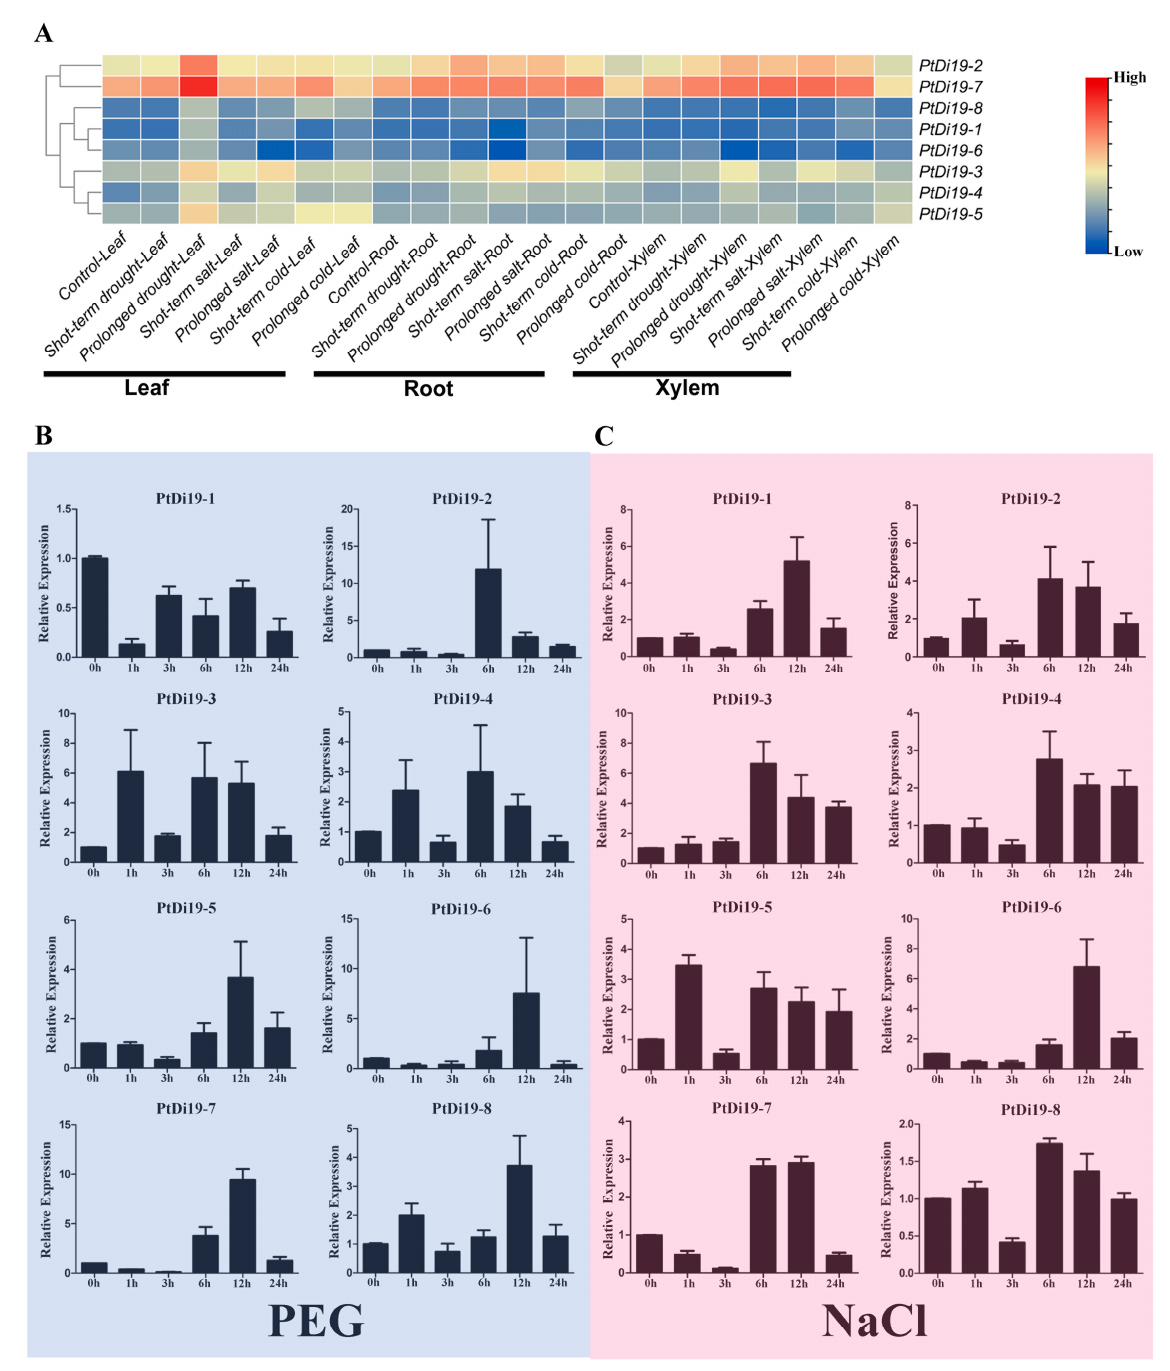
Figure 3. RNA-seq and qRT-PCR analysis of PtDi19 genes under stress. ( A ) Heat maps of the expression levels of eight PtDi19 genes in different tissues under drought, salt, and cold treatment. The legend was to show the relative high and low expressions, value = log 2 (fold change). ( B , C ) The induced expression pattern of PtDi19 with 20% PEG 6000 and 200 mmol/L NaCl root irrigation, respectively. The Y -axis indicates the relative expression levels, and 0 h, 1 h, 3 h, 6 h, 12 h, and 24 h ( X -axis) indicate hours of